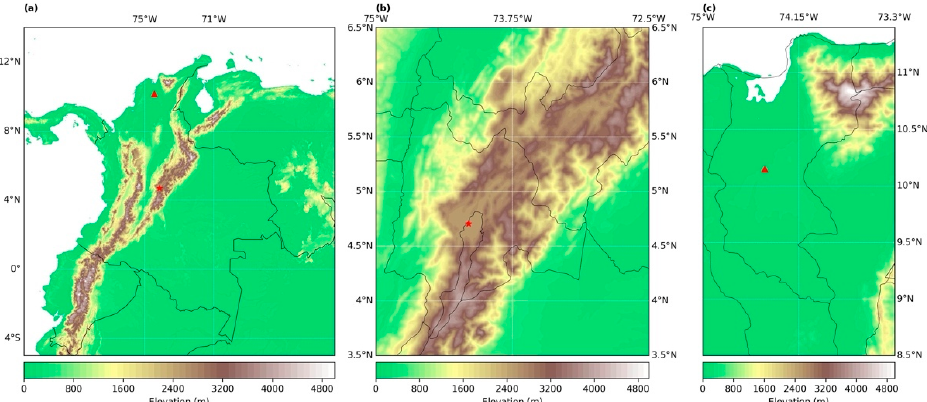
Figure 1. ( a ) Location of Colombia , with Cundinamarca-Bogotá (star) and Magdalena (triangle) and its surrounding topography. ( b ) Close up of the surroundings of the Cundinamarca-Bogotá departments. ( c ) Close up of the surroundings of the Magdalena Department. The black lines of panels b and c represent the political division of the country.